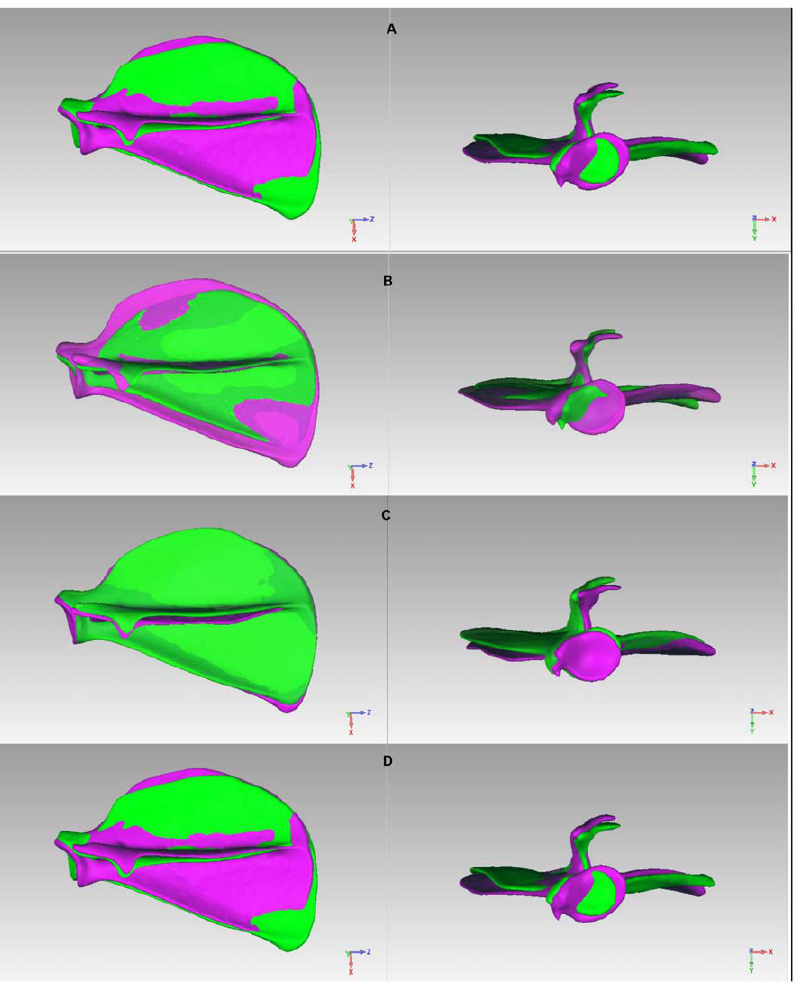
p is in purple; model with { 2 ffiffiffi l